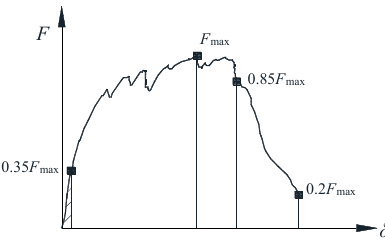
Figure 11. Flexural toughness evaluation method based on peak load.